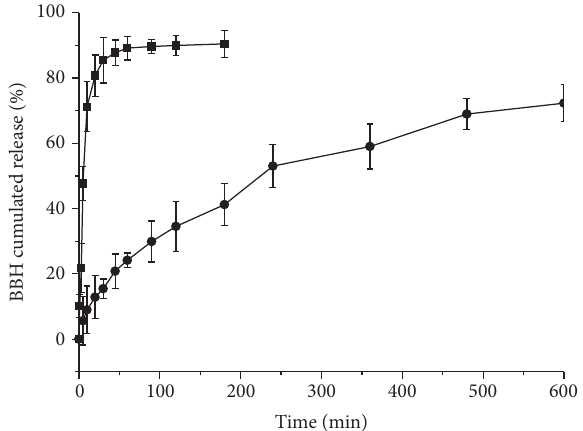
Figure 3: In vitro release testing of different BBH preparations at 37 ∘ C in simulated gastric fluid. The preparations tested were BBH commercial tablets (- ◼ -) and chitosan-coated alginate/gelatin BBH loaded microspheres (- e